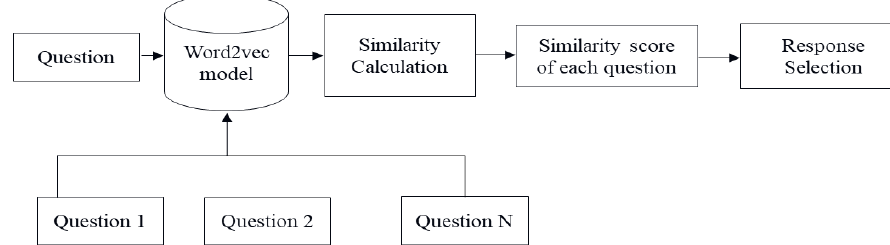
Figure 7. FAQ dataset used for similarity calculation.